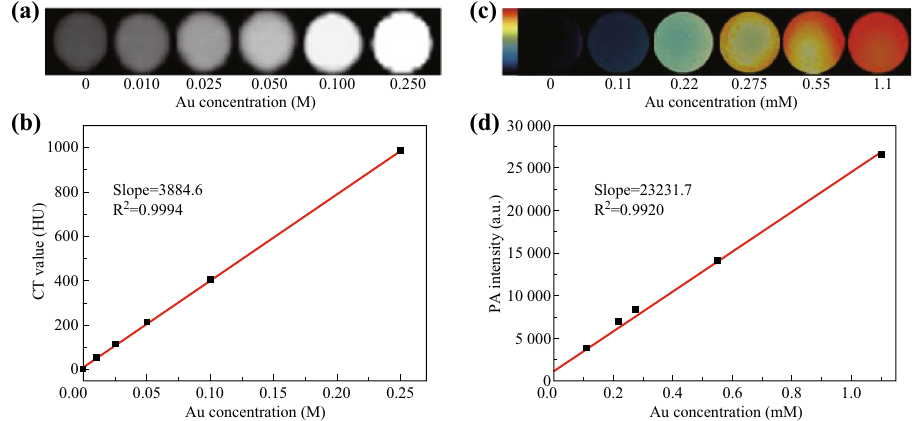
Fig. 5 a CT images of AuNR@PAA/CaP yolk–shell NPs and b linear relationship of CT signal intensities versus Au concentrations, c PA images and d linear relationship of PA signal intensities with different Au